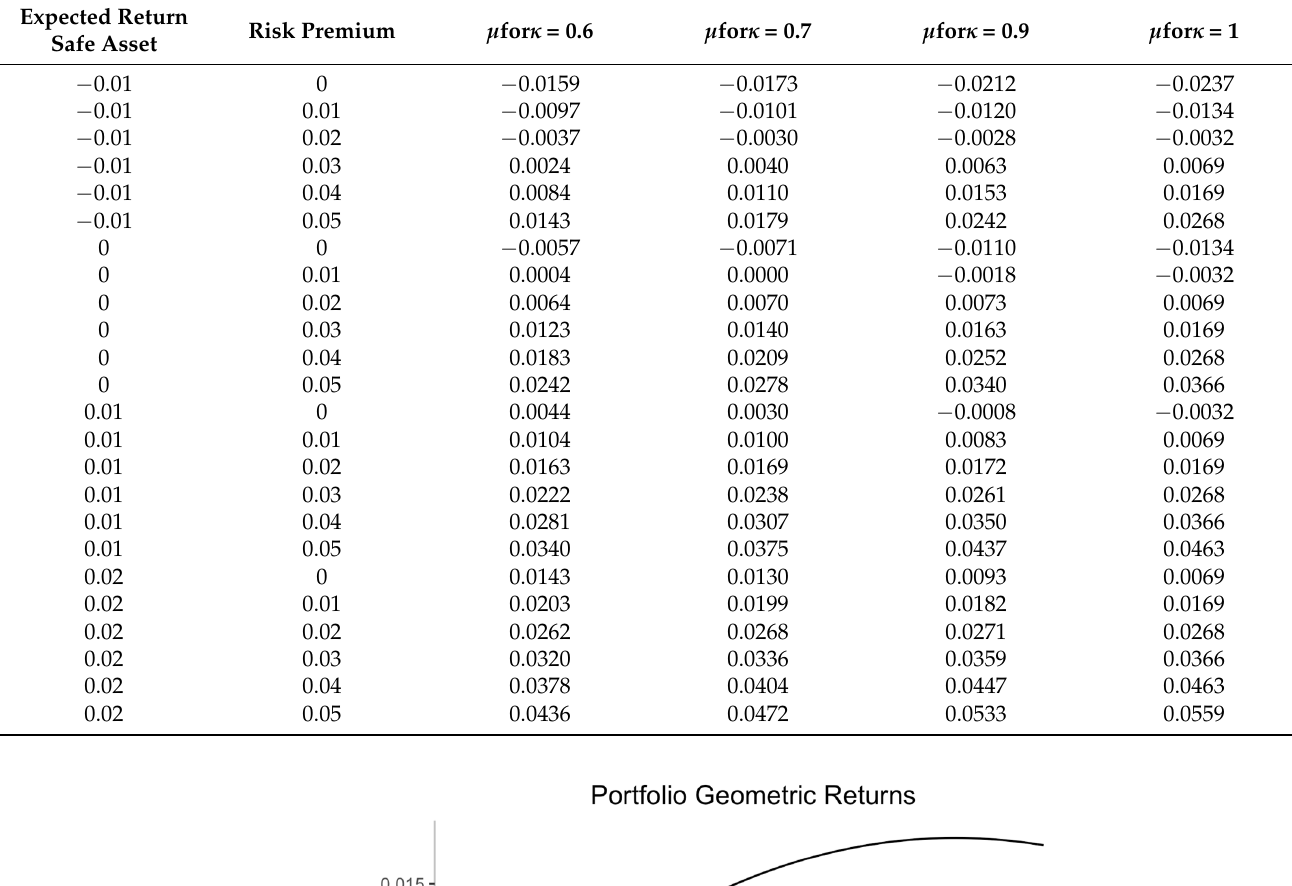
Table 1. Log Returns, Risk Premiums, and Asset Allocation.